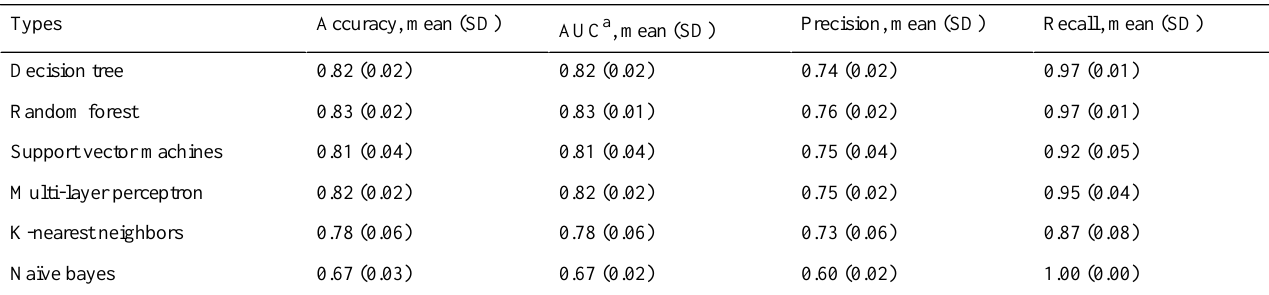
Table 8. Mean performance metrics and respective SDs (in years) for the classification of minor versus adults for the female subjects.